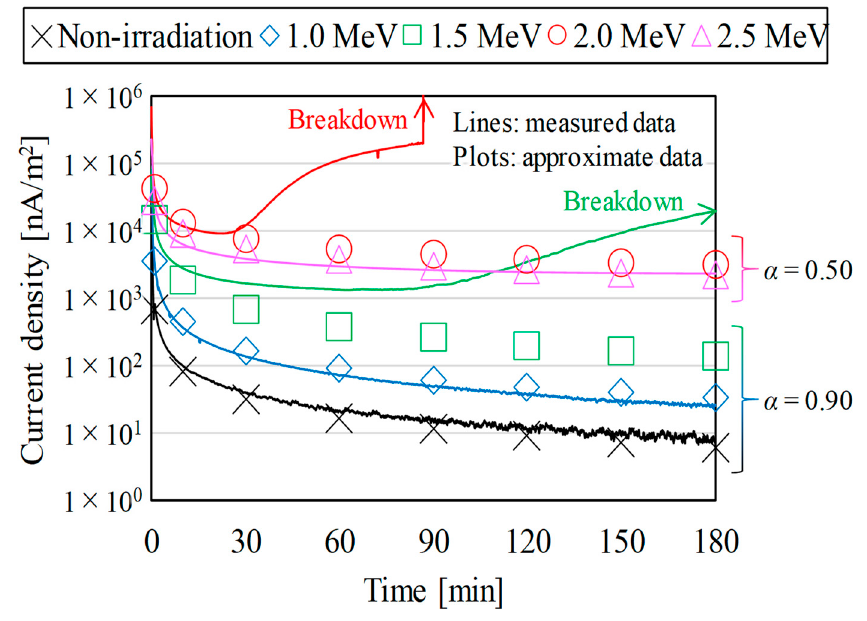
Figure 3. The irradiation energy dependence of the current density through the bulks of the proton irradiated samples after 1 day of irradiation.